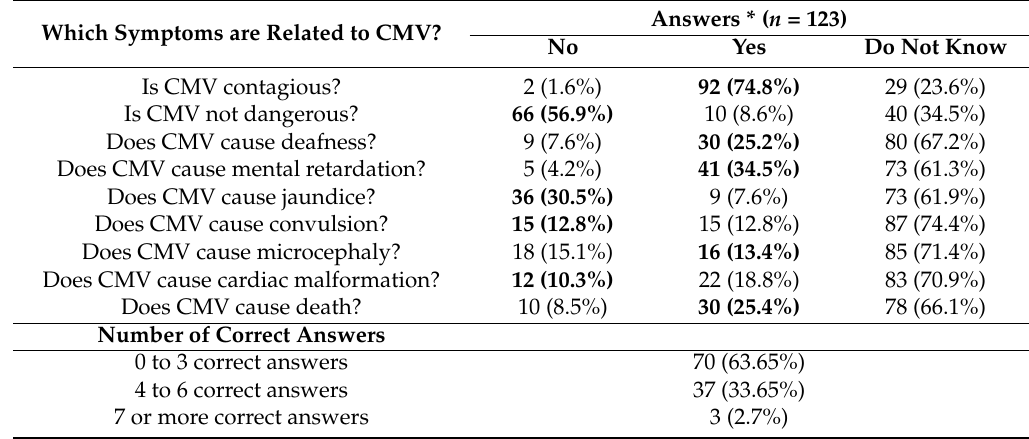
Table 3. Specific knowledge about CMV symptoms among women who have heard of CMV. Which Symptoms are Related to CMV?